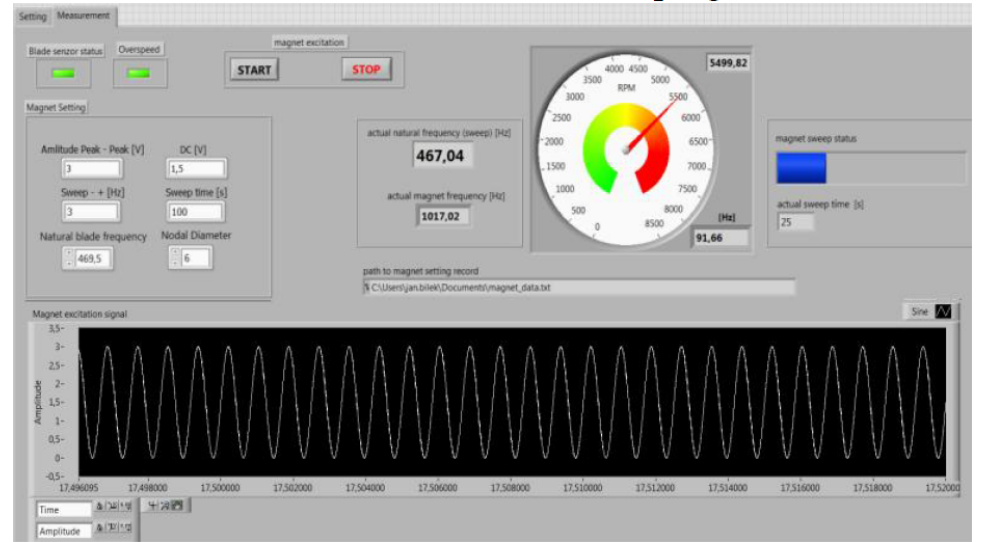
Figure 8. Measurement and excitation LabVIEW user